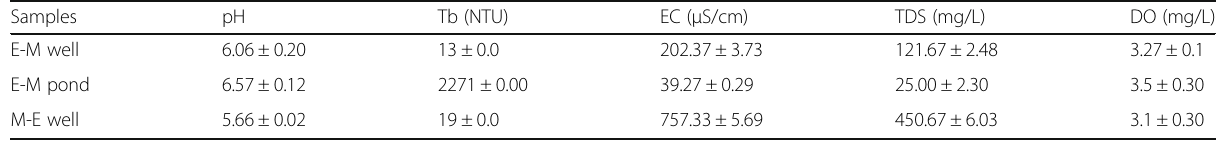
Table 2 Physicochemical property of water samples